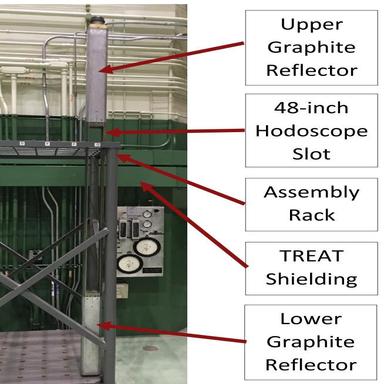
TREAT 48 in. (121.92 cm) Access Hole (Slotted) Assembly.